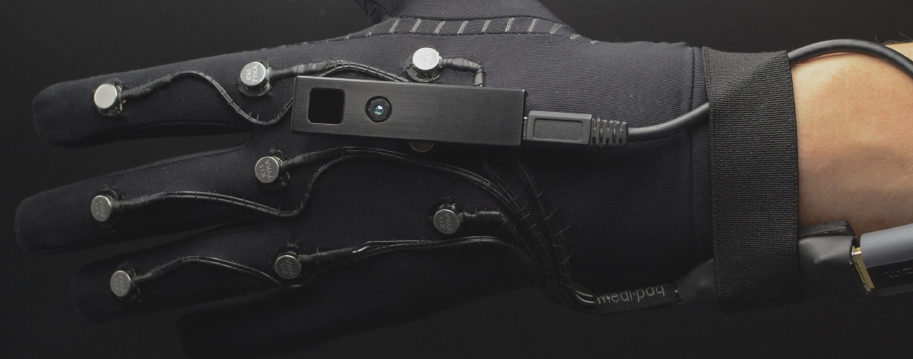
Figure A2. The matrix of 3 × 3 LRA vibration motors forming the haptic interface of the prototypes— in this case an early prototype is shown.